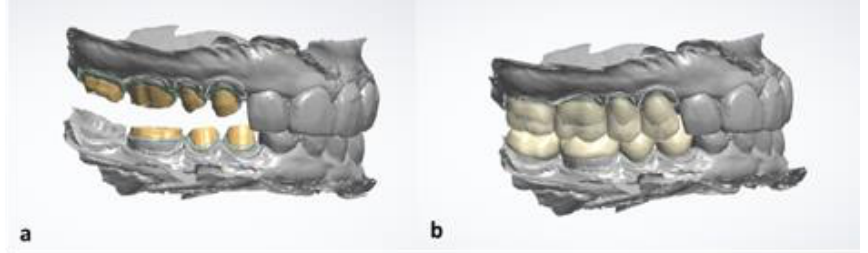
Figure 10. Teeth preparations on Dental Designer software ( a ), modeling of the prosthetic elements according to the mock-up ( b ).